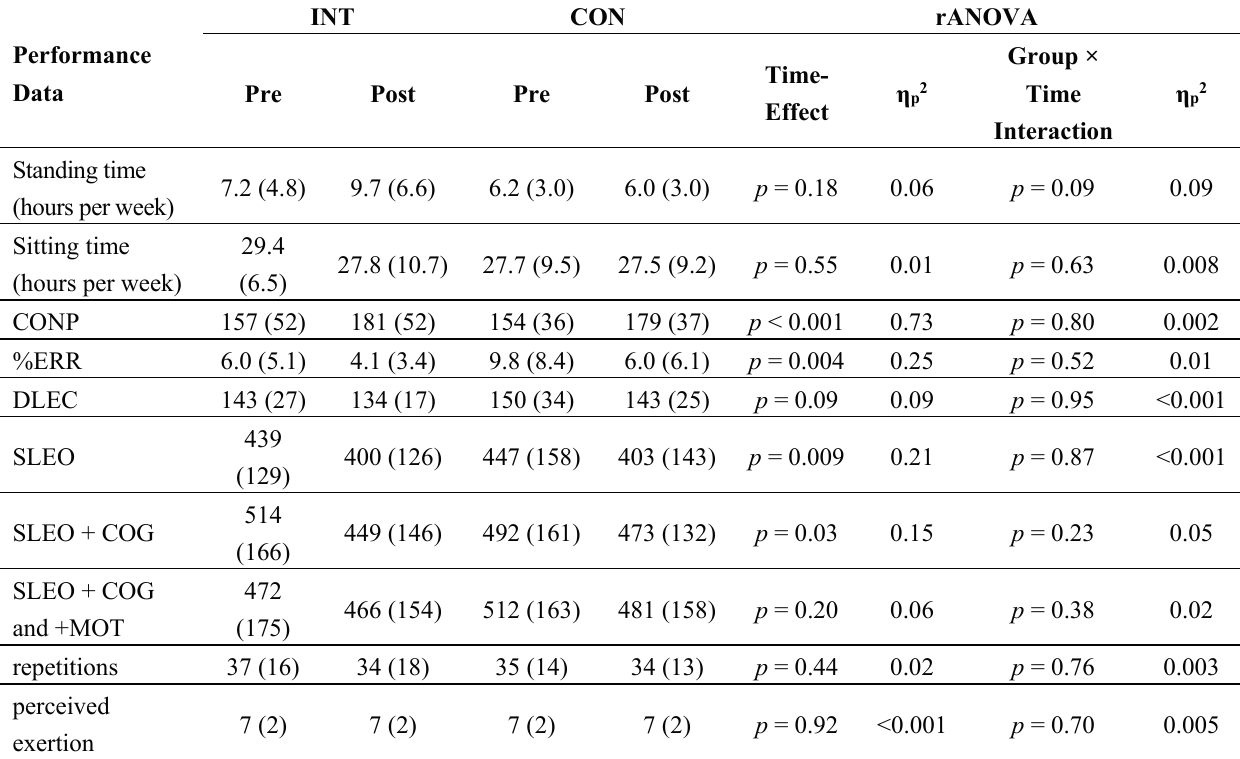
Table 2 Standing times (hours per week), concentration (d2-test), balance (postural sway) and strength (heel-rise test) performance for INT and CON during pre and post